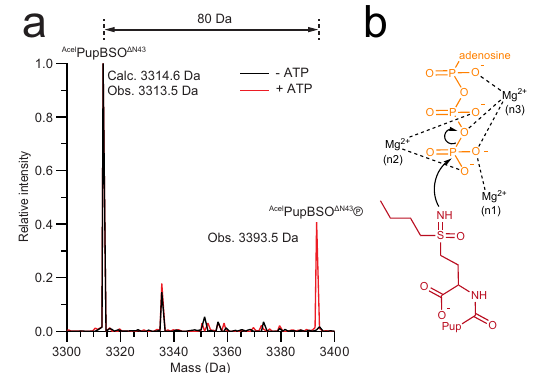
Fig. 4 Dop phosphorylates a Pup derivative carrying a C-terminal buthionine sulfoximine (BSO). a Mass spectrometry analysis reveals the production of phosphorylated PupBSO by Dop in the presence of ATP. b Proposed reaction mechanism of Acel PupBSO Δ N43 phosphorylation by Dop in the presence